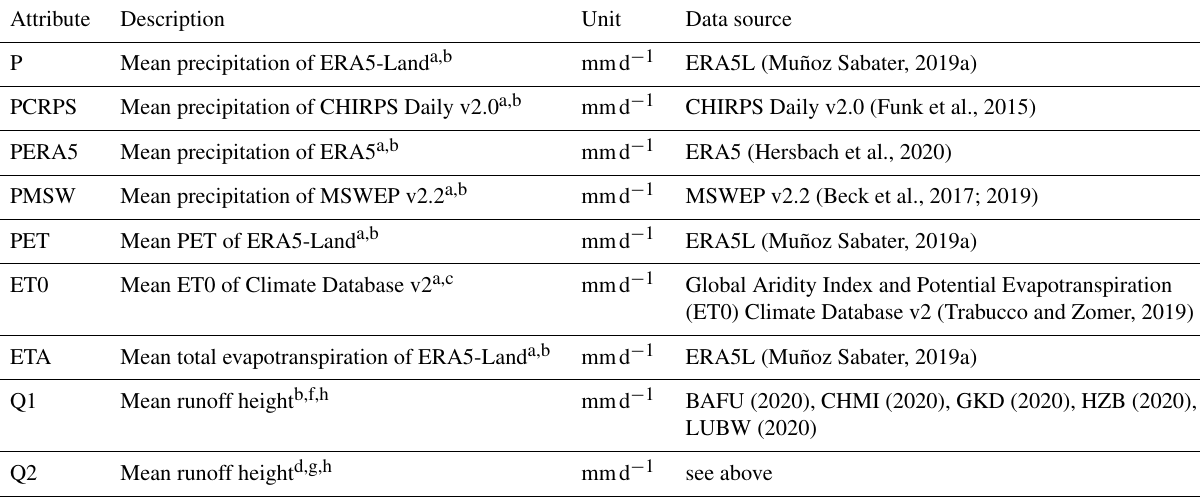
Table A10. Attributes in the accompanying file Water_balance.csv. e